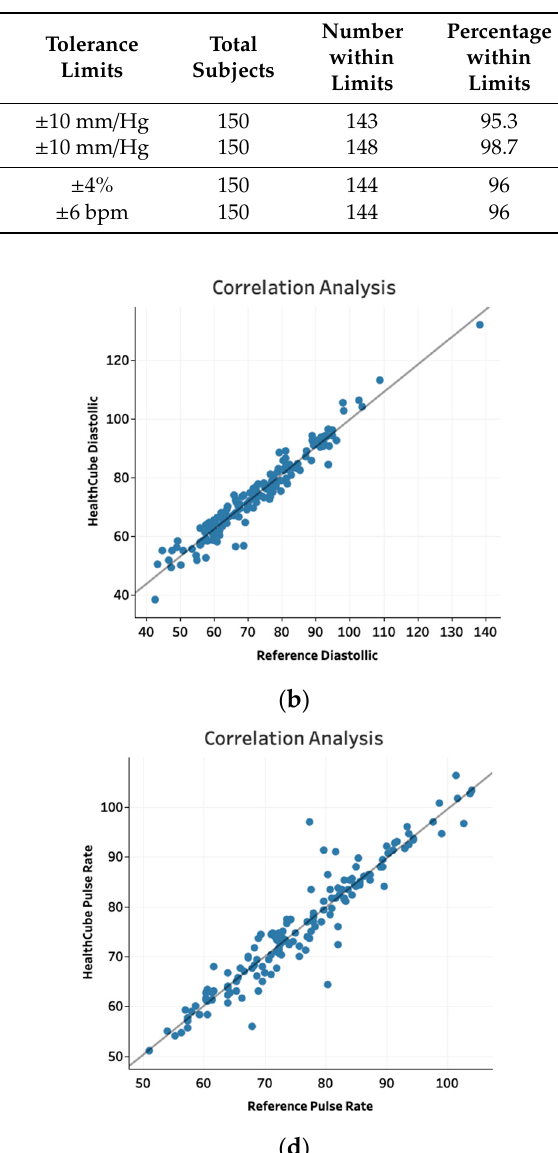
Table 5. Fit of data within specific ranges for systolic and diastolic pressure, oxygen saturation and pulse rate.